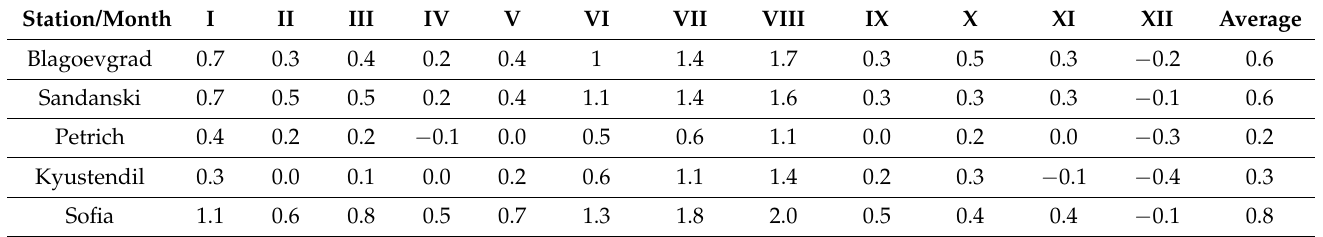
Table 7. Average monthly temperatures deviations in southwestern Bulgaria in the period